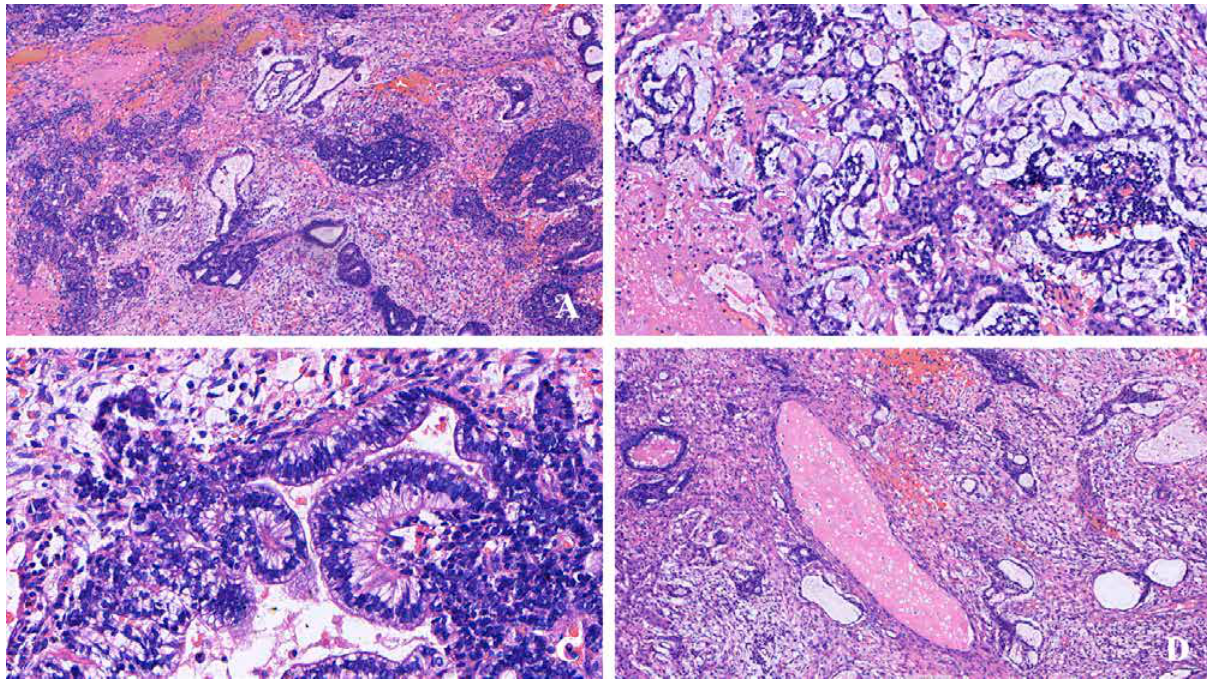
Figure 2: Histology of the mixed germ cell tumor. A) Low power photomicrograph showing mixed GCT with yolk sac tumor and embryonal carcinoma components (magnification: ×100). B) A representative histological image of reticular and microcystic architectures of yolk sac tumor components (magnification: ×400). C) A representative histological image of embryonal glands lined by columnar cells (×400). D) A representative histological image of mature teratoma in the form of mature bone tissue within the tumor (magnification: